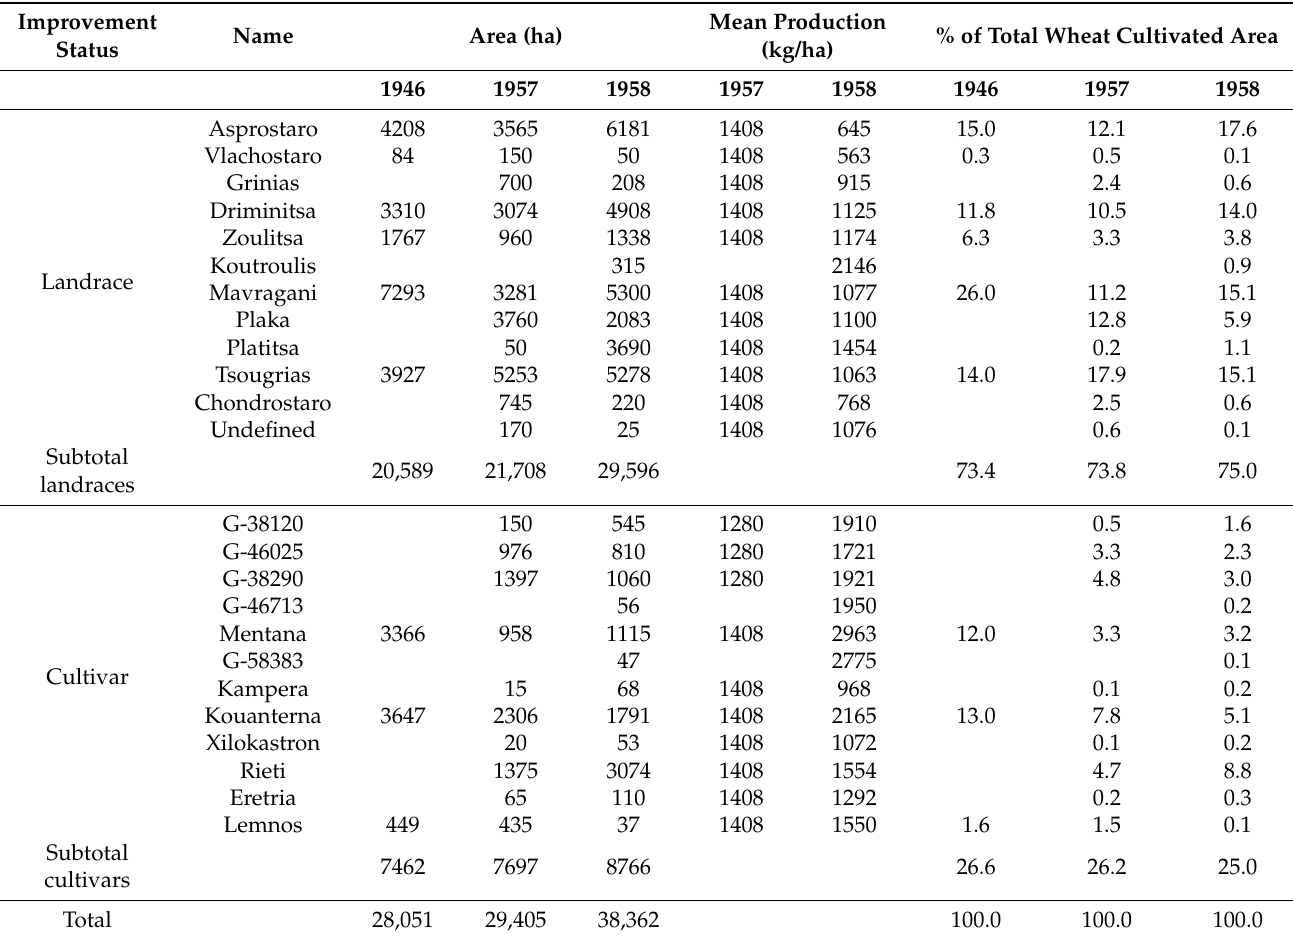
Table 4. Wheat landraces and cultivars grown in Arcadia during 1946, 1957, and 1958 (adapted from Kokolios [44,45]).